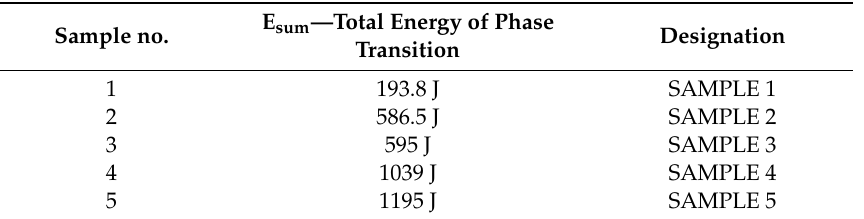
Table 1. Total energy of phase transition.